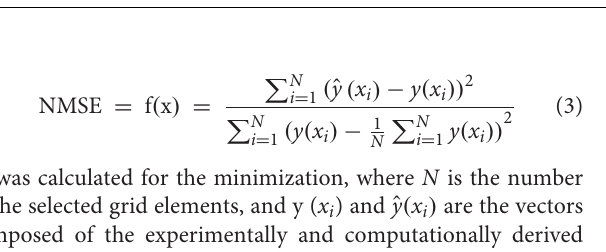
FIGURE 3 | Image registration composed of the registration of lumen and external elastic lamina (EEL) borders of the magnetic resonance imaging (MRI) to the ultrasound to obtain the transformation matrix (Step 1), and the application of the transformation matrix to the complete segmented MRI image (Step